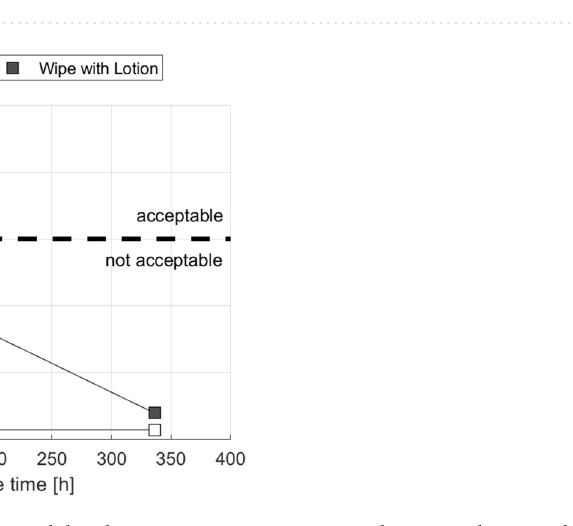
Figure 2. Reduction of wet wipe dispersibility due to wipe storage in water and wet-wipe lotion. Below a value of 60% dispersibility is insufficient according to INDA/EDANA 15 . Sample P.BB.20 made of bleached kraft pulp and round viscose fibre B was